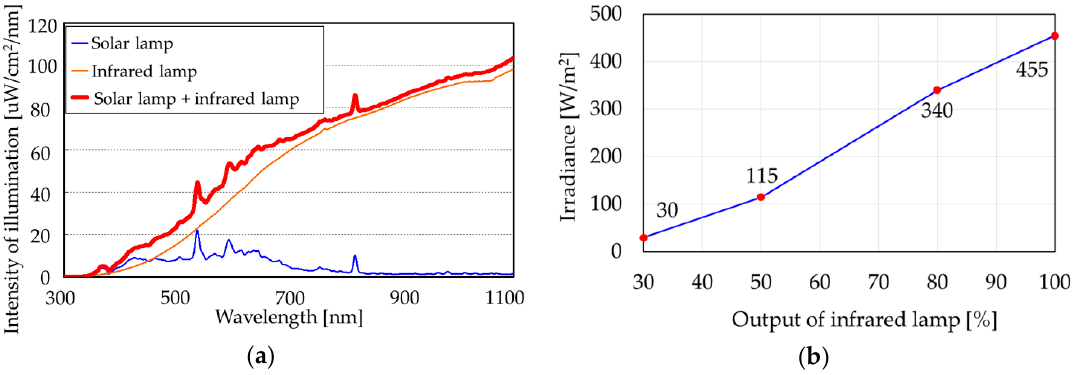
Figure 14. Intensity of illumination and irradiance: ( a ) Intensity of illumination according to wavelength; ( b ) Irradiance according to output of infrared lamp.